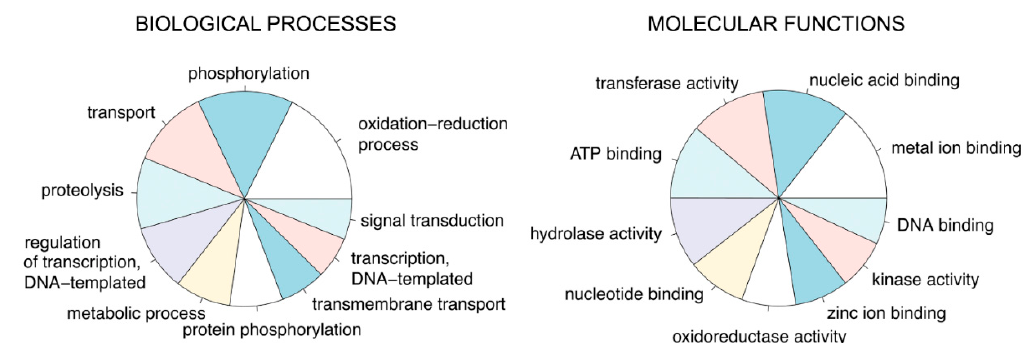
Figure 6. Graphical representation of the functional annotation of the transcriptome assembled in this work. Pie charts are realized using the CRAN platform and show the percentage of the 10 most represented gene ontology (GO) terms for Biological Processes and Molecular Functions. The categories are not terminal nodes in the GO hierarchy. The full list of categories is reported in Supplementary Table S3.